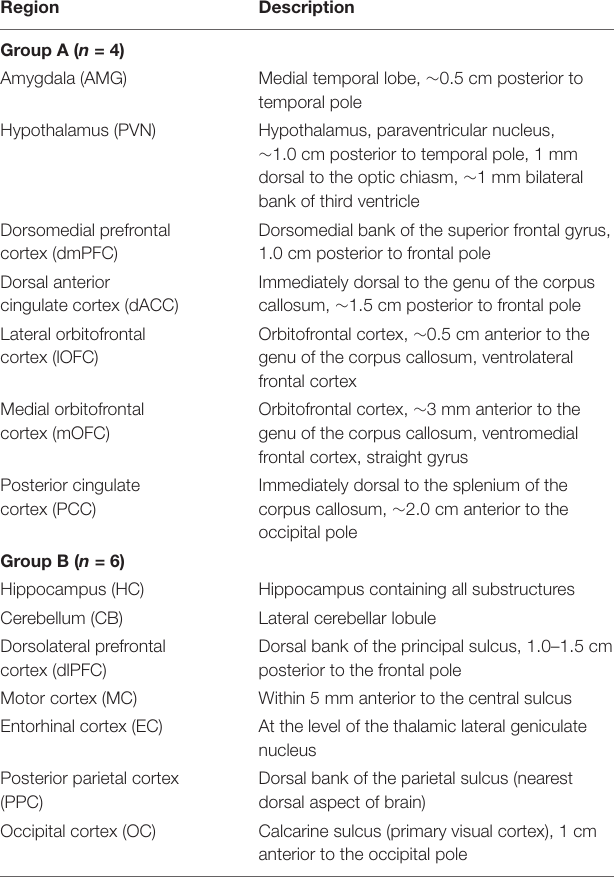
TABLE 1 | Description of brain regions examined. TABLE 2 | miRNAs that are nominally correlated between blood and mean brain levels for expression in both study